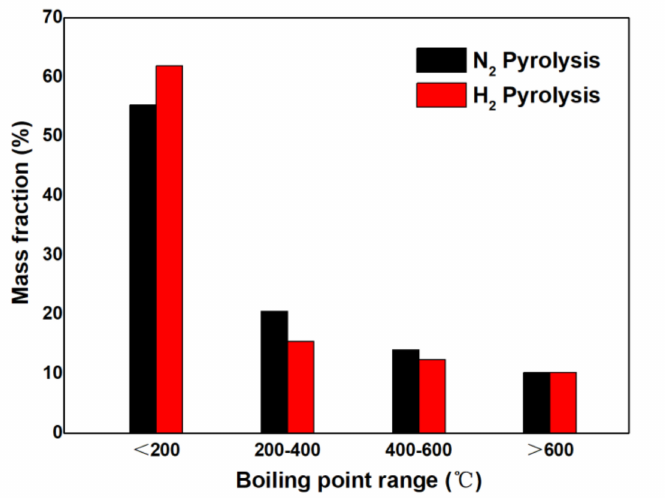
Figure 5. Weight loss rate of pyrolysis bio-oils in different atmospheres at different tempera- ture ranges.